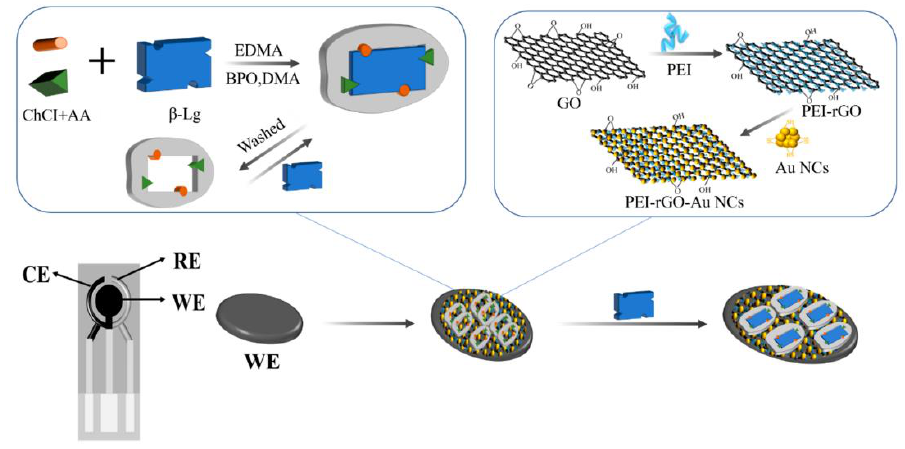
Figure 17. Scheme of the MIP synthesis and of the electrochemical sensor assembly. Reprinted from [178].